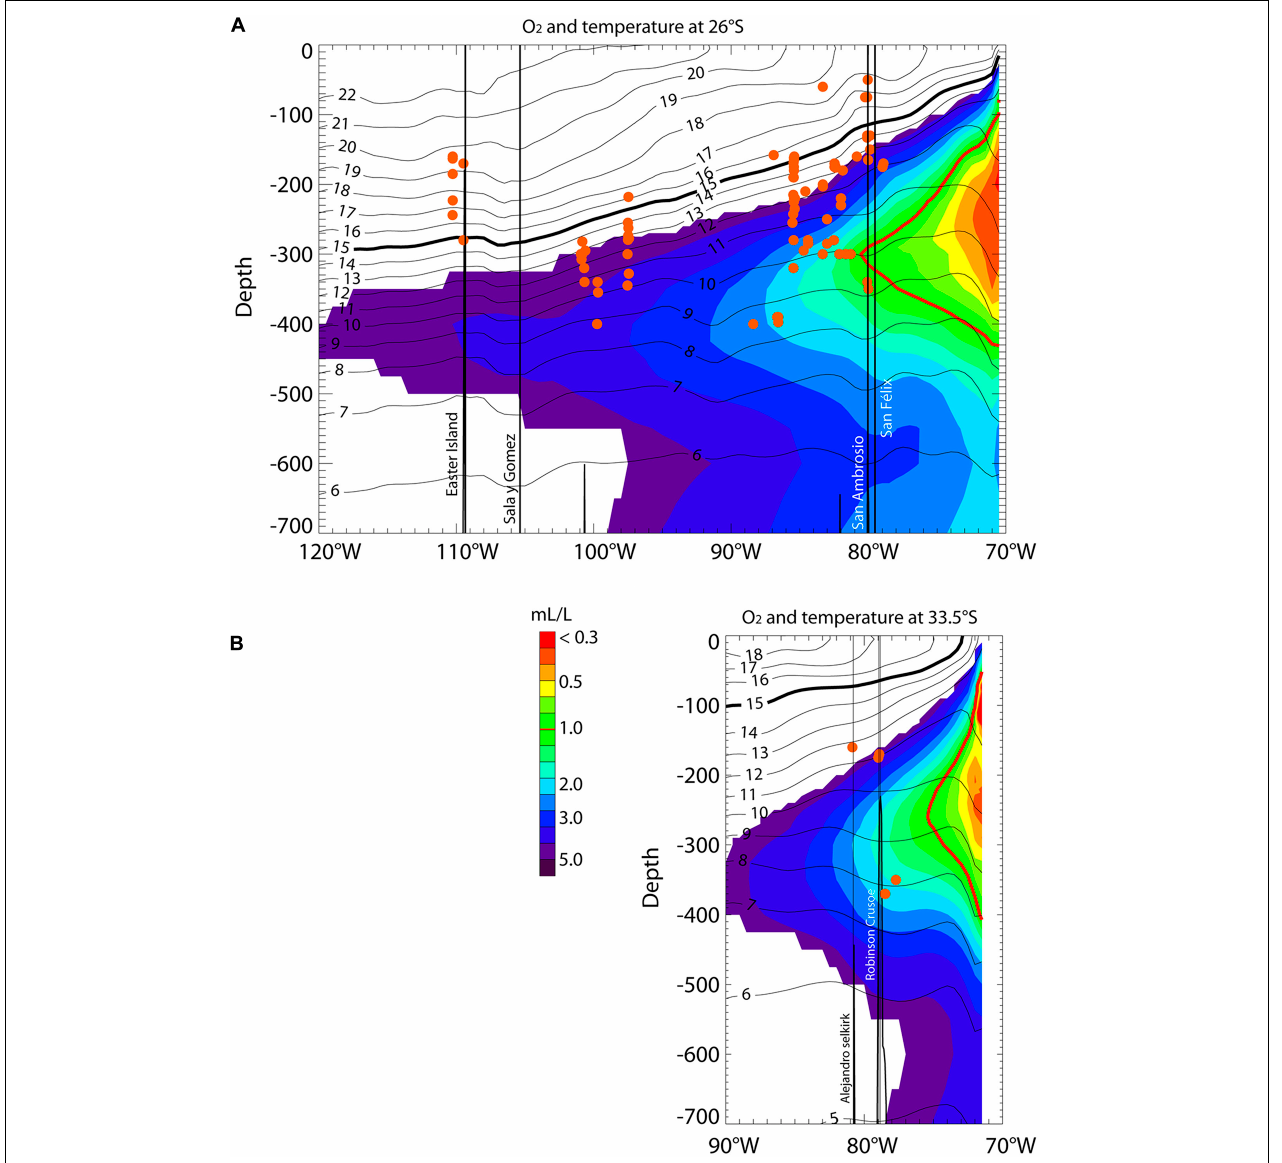
FIGURE 2 | Longitudinal sections at 26 ◦ S (A) and 33.5 ◦ S (B) of mean dissolved oxygen (color) and temperature (contours) between 0 and 700 m. Data are from CARS (see section “Environmental Data”). The thick black line represents the 15 ◦ C isotherm, which is a proxy for thermocline depth. The thick red line corresponds to the 1 mL/L isopleths and can be considered the limit of the Oxygen Minimum Zone. The red dots indicate the depth of all the stations. The labeled vertical black lines indicate islands. San Ambrosio and San Felix islands belong to the Desventuradas archipelago (B) , while the Alejandro and Robinson islands indicate the area of the Juan Fernandez